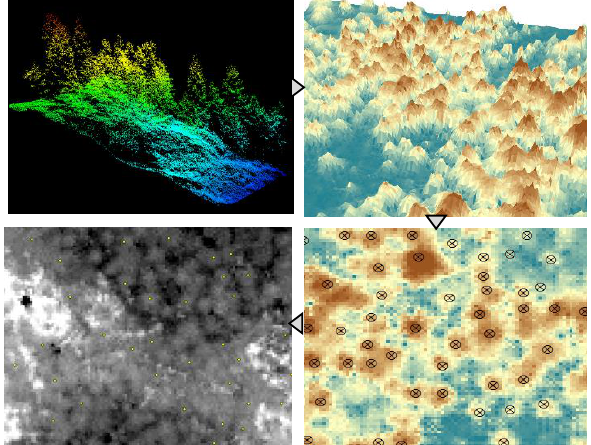
Figure 11. Georeferencing process of UAV-borne imagery: 1) canopy height model derivation, 2) tree tops identification, 3) registration to CHM on “tree to tree” basis .